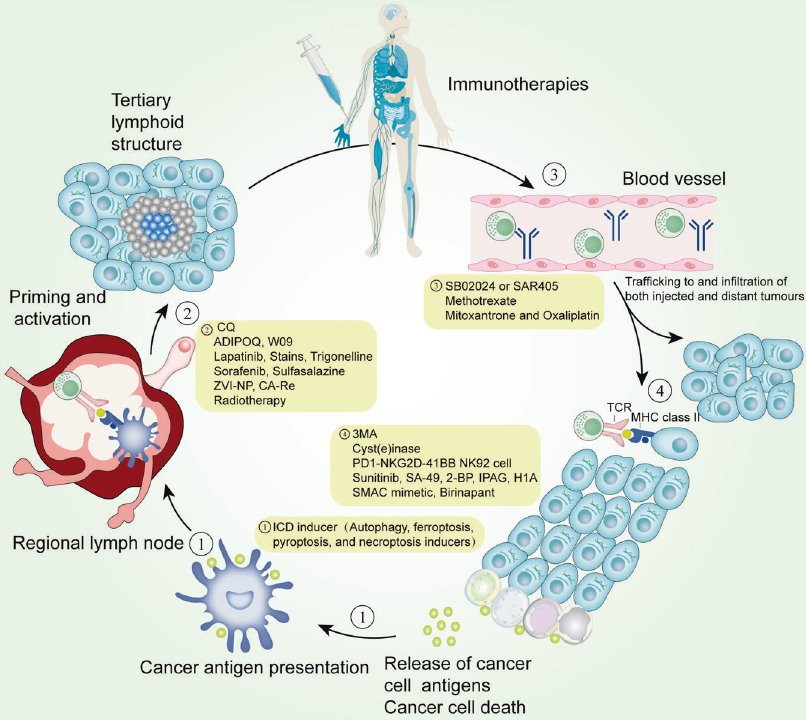
Fig. 5 Targeting autophagy, ferroptosis, pyroptosis, and necroptosis for tumor immunotherapy in cancer immunity cycle. Five key processes of cancer immunity cycle are noted in the fi gure. Agents that target autophagy, ferroptosis, pyroptosis, and necroptosis act synergistically with antitumor immunotherapy on different step of cancer immunity cycle (Autophagy inhibitor: CQ, SB02024, SAR405, 3MA; Autophagy inducer: ADIPOQ, W09, Mitoxantrone, Oxaliplatin, Sunitinib, SA-49, 2-BP, IPAG, H1A; Ferroptosis inducer: Lapatinib, Stains, Trigonelline, Sorafenib, Sulfasalazine, Cyst(e)inase, ZVI-NP; Pyroptosis inducer: Radiotherapy, Methotrexate, PD1-NKG2D-41BB NK92 cell, CA-Re; Necroptosis inducer: SMAC mimetic,